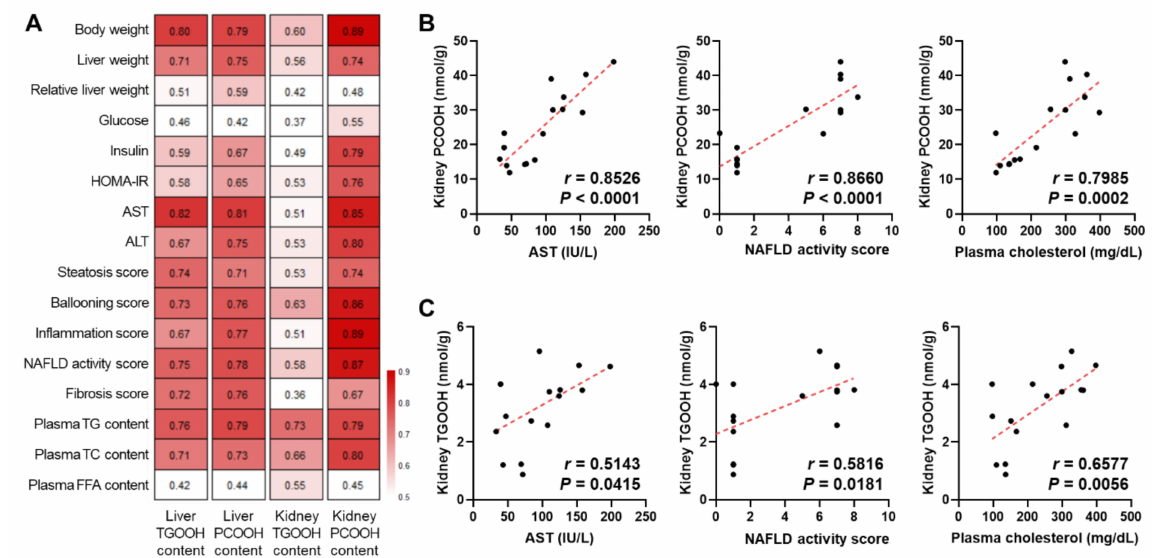
Figure 6. ( A ) Heatmap of the Pearson correlation coefficients between the organ lipid hydroperoxides and the physiological, histological, and blood data. ( B ) Scatter plots of kidney total PCOOH content and representative NASH-related biological indexes. ( C ) Scatter plots of kidney total TGOOH content and representative NASH-related biological